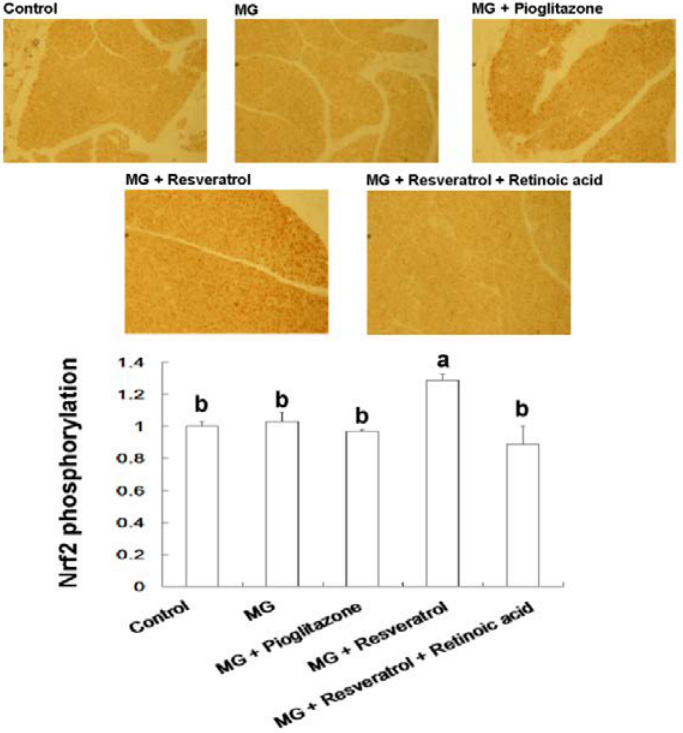
Figure 6. Immunohistochemical visualization of pancreatic p-Nrf2 in methylglyoxal-treated mice with resveratrol ( n = 6). The bars show the pancreatic cellular content of p-Nrf2 of different treatment groups. (a,b) indicate a statistically-significant difference at p <